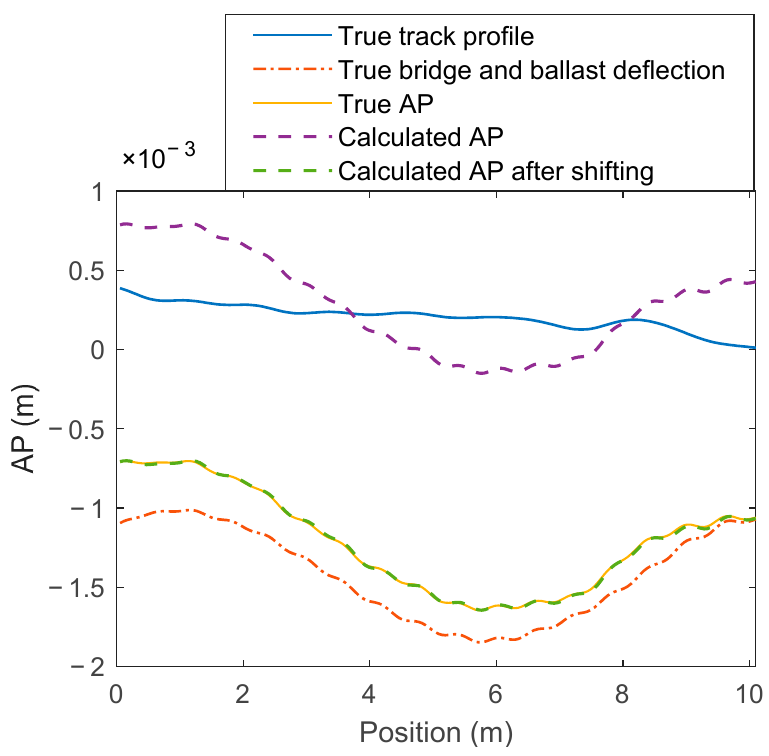
Figure 11. The true and calculated AP of the bridge from one run over Profile 1, State 7.